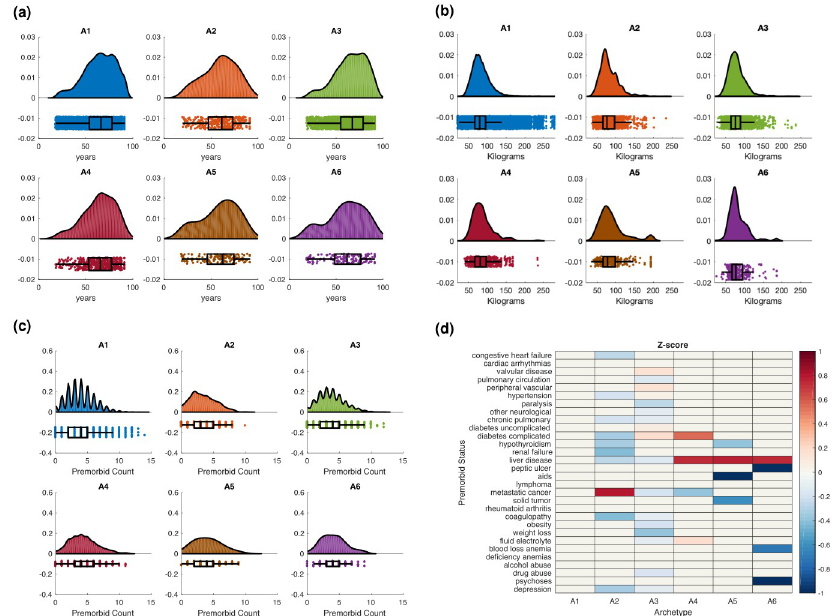
Fig 5. (A) The population distribution for each sepsis type stratified by age. (B) The population distribution for each sepsis type stratified by weight. (C) The population distribution for each sepsis type stratified by the number of comorbidities before infection. (D) Z-score analysis of the comorbidity profiles (row) of each sepsis type (column). Entries approaching red in intensity indicate that the comorbidity profiles are expressed in the corresponding sepsis states, and entries closer to blue indicate that the comorbidity profiles are suppressed in corresponding sepsis states. Entries with p-value > 0.05. are set to 0.